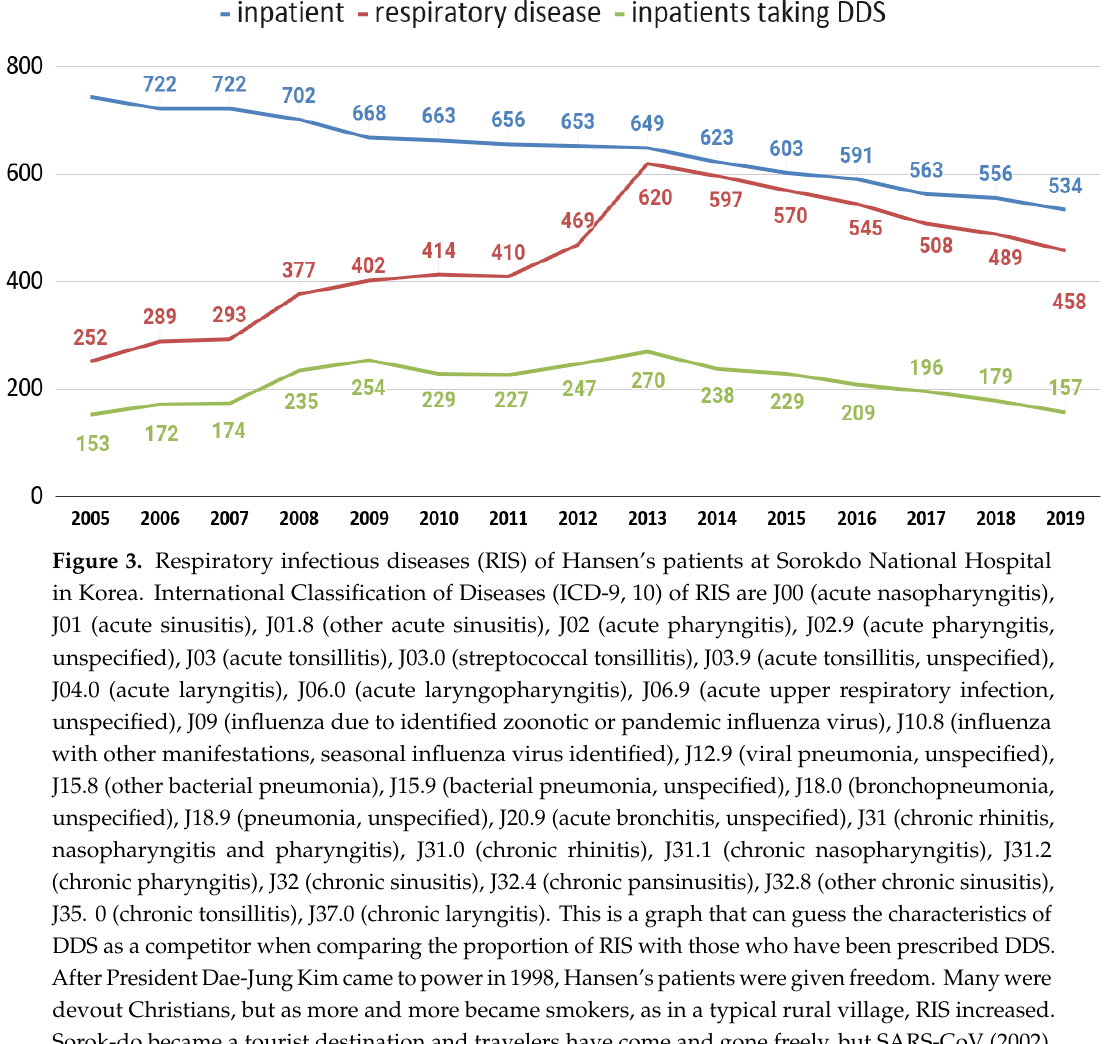
Table 3. Age distribution of Hansen’s disease in Korea (2019): Hansen’s disease status and major